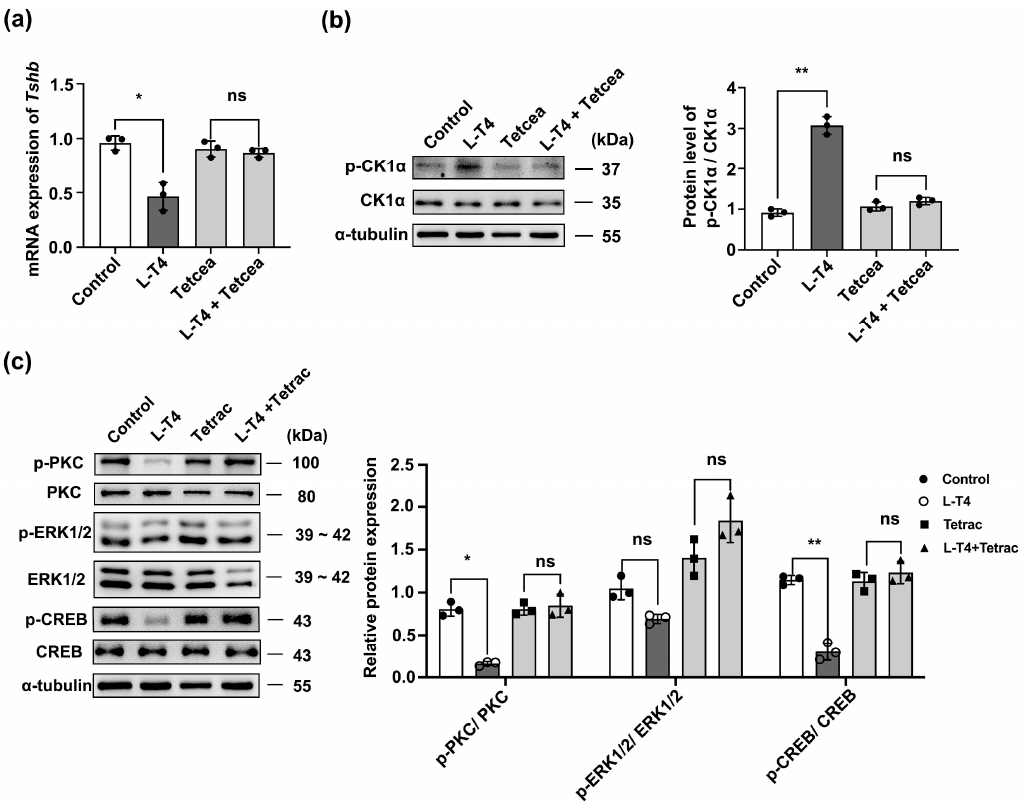
Figure 8. L-T4- α V β 3 activates the post-translational modi fi cation of CK1 α to inhibit PKC/ERK/CREB signaling and downregulate TSH synthesis. ( a ) Relative Tshb mRNA levels after treatment for 1 h with 10 mM α V β 3 integrin inhibitor or α V β 3 integrin inhibitor pre-incubation followed by 10 mM L-T4 treatment. Tshb mRNA levels were normalized to Gapdh ; * p < 0.05 and ns = no signi fi cant, n = 3. ( b ) Expression of p-CK1 α /CK1 α determined using Western blo tt ing; CK1 α was used as the internal reference. ** p < 0.01 and ns = no signi fi cant, n = 3. ( c ) Protein expression in primary cultured murine pituitary cells after pre-incubation with 10 mM α V β 3 integrin inhibitor or α V β 3 integrin inhibitor pre-incubation followed by 10 mM L-T4 treatment quanti fi ed using Western blo tt ing and normalized to PKC, ERK1/2, and CREB expression levels; * p < 0.05, ** p < 0.01 and ns = no signi fi cant, n = 3. Each experiment was independently repeated three times.